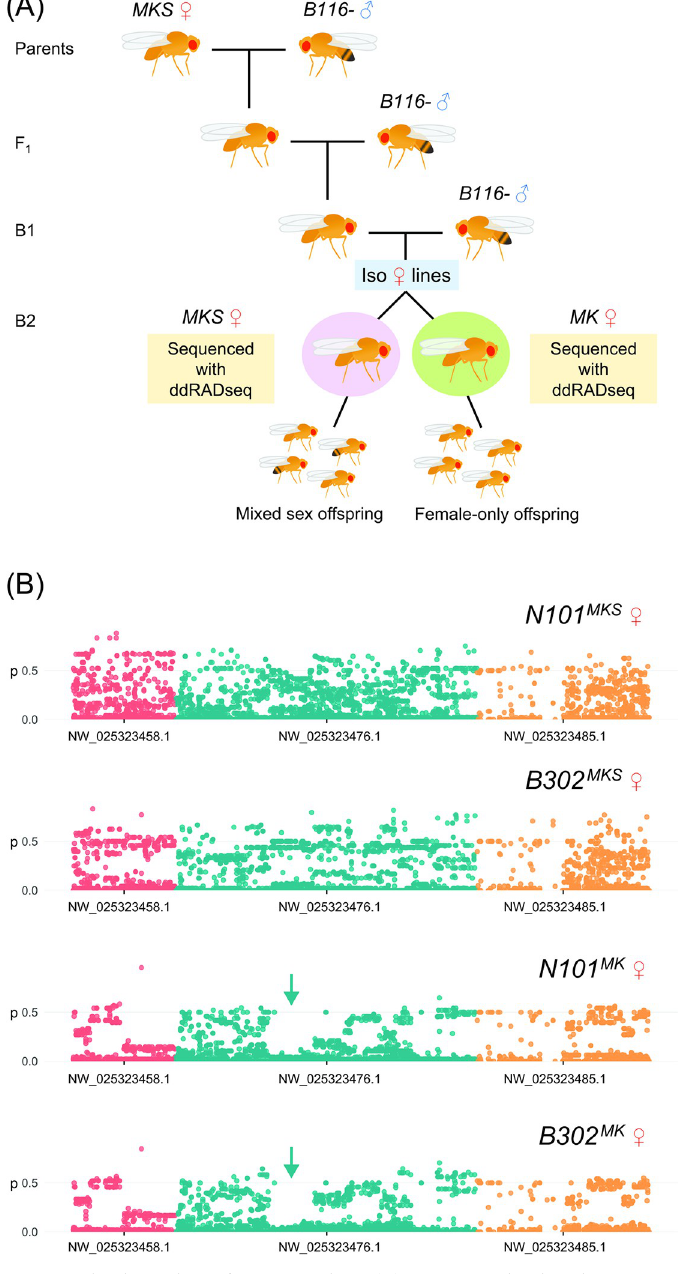
Fig 2. Molecular analysis of segregating lines; (A) is a cartoon detailing the experimental crosses and (B) shows frequency plots of non-reference alleles on the 3 contigs where structure followed MK suppression phenotype. A selective sweep pattern denoted by arrows is apparent on the NW_02532476.1 contig. The data underlying this figure can be found in